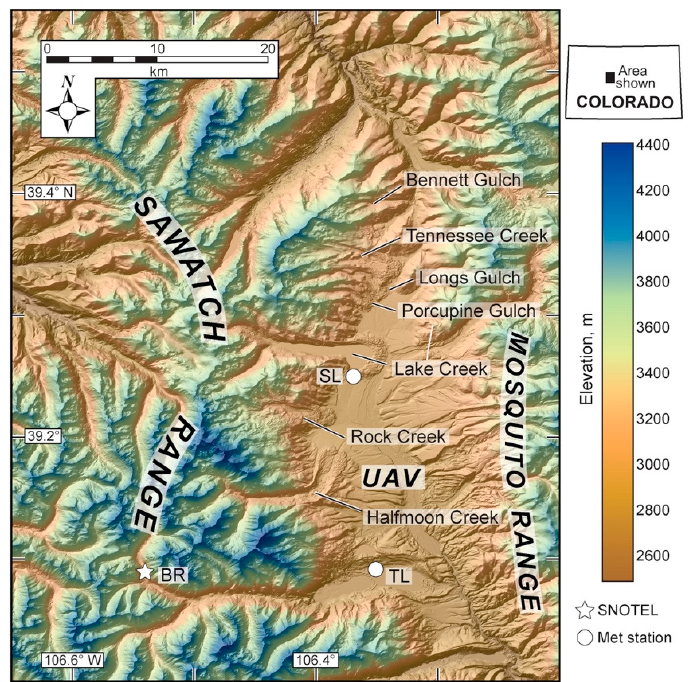
Figure 1. Location map of the study area. Abbreviations: BR—Brumley SNOTEL; SL—Sugarloaf meteorological station; TL—Twin Lakes meteorological station; UAV—Upper Arkansas Valley. Basemap was generated from U.S. Geological Survey 10-meter National Elevation Dataset (NED) data and Global Mapper software